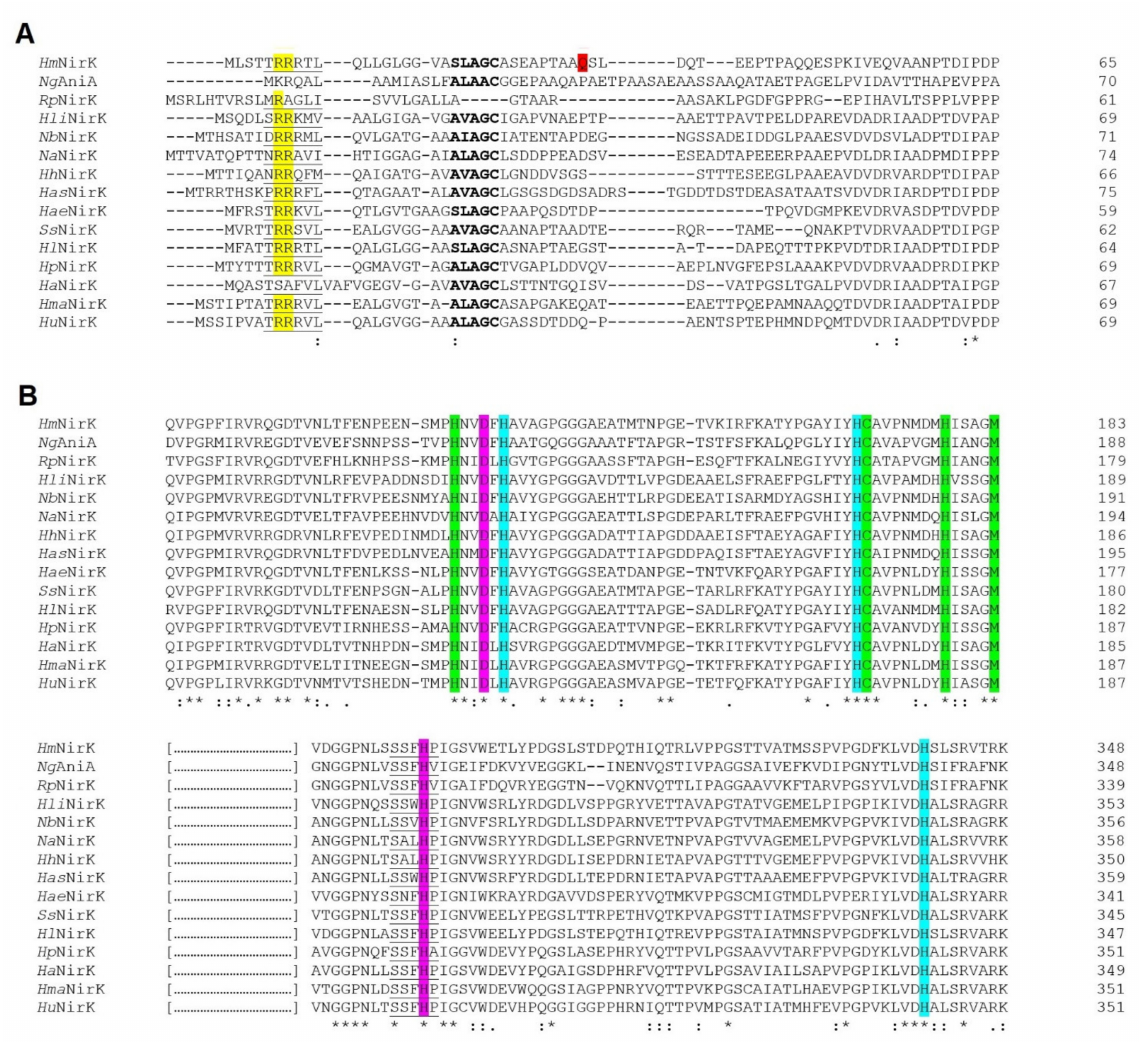
Figure 5. Clustal omega alignment of Neisseria gonorrhoeae ( Ng AniA; Protein NCBI ID: WP_003705926.1), Ralstonia